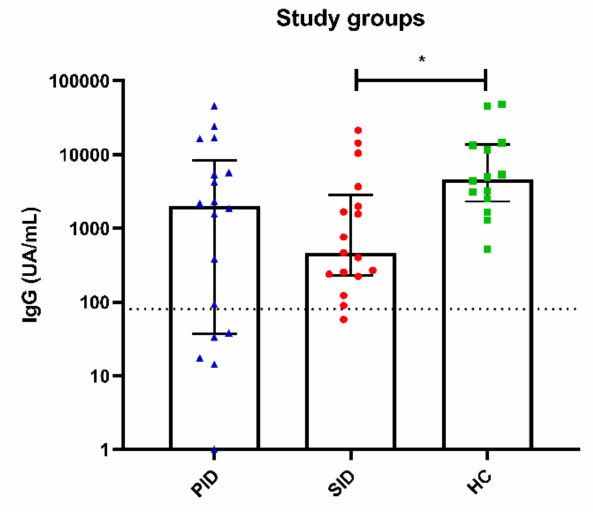
Figure 4. Antibody anti-SARS-CoV-2 responses measured by chemiluminescent microparticle im- munoassay in the three study groups, PID represented with blue triangles, SID with red circles and HC with green squares. SID to B-CLPD mounted significantly lower IgG titers than HC. * Significant differences ( p <